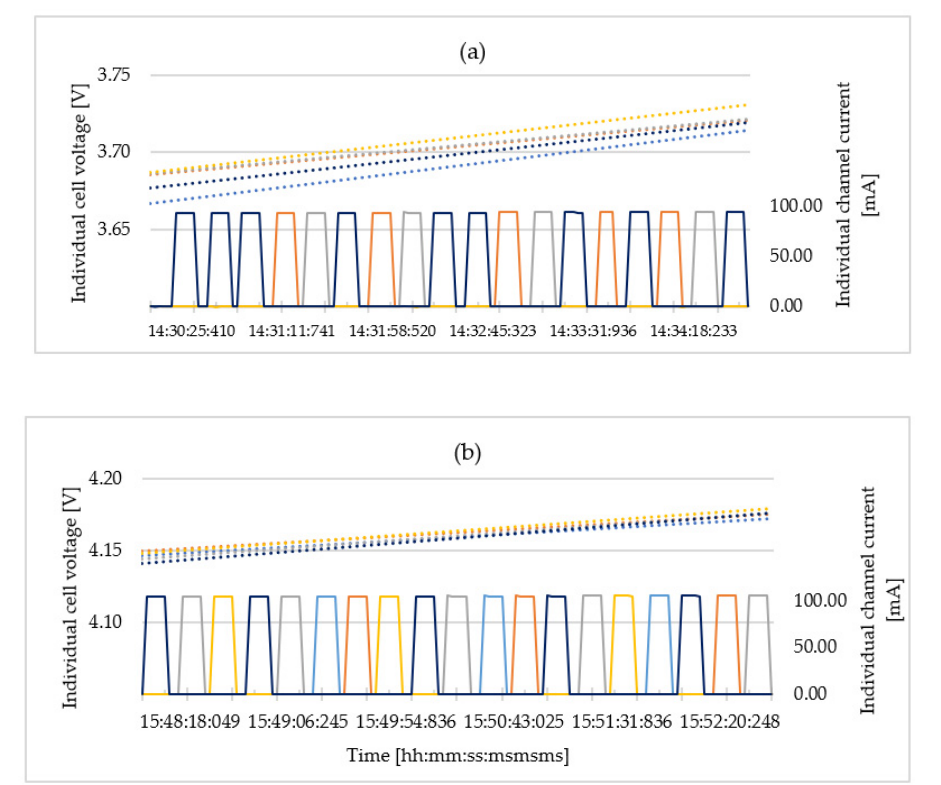
Figure 15. Initial ( a ) and final ( b ) battery ‐ cell voltage (trendlines) and balancing channels current oscillograms in the charge system configuration.